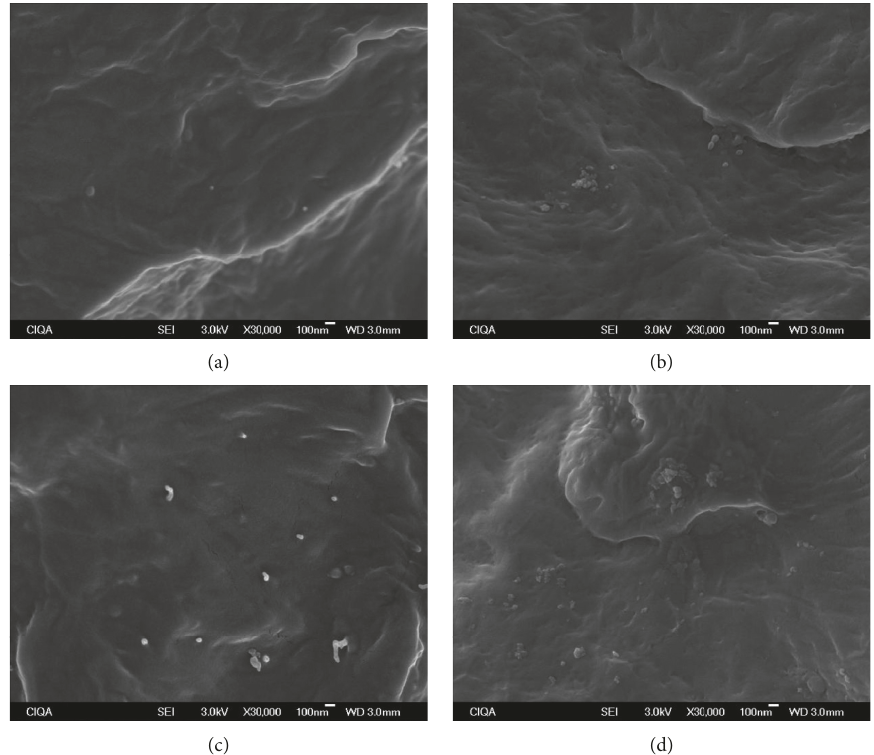
Figure 3: Fractured surface of the nanocomposites: (a) 0.01, (b) 0.05, (c) 0.10, and (d) 0.50 wt.% of copper nanoparticles.